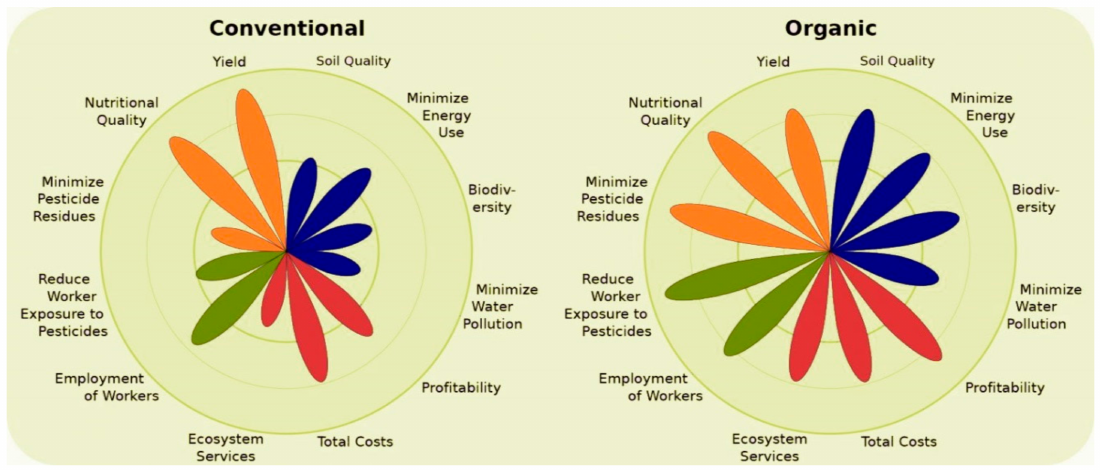
Figure 1. Difference between conventional and organic farming